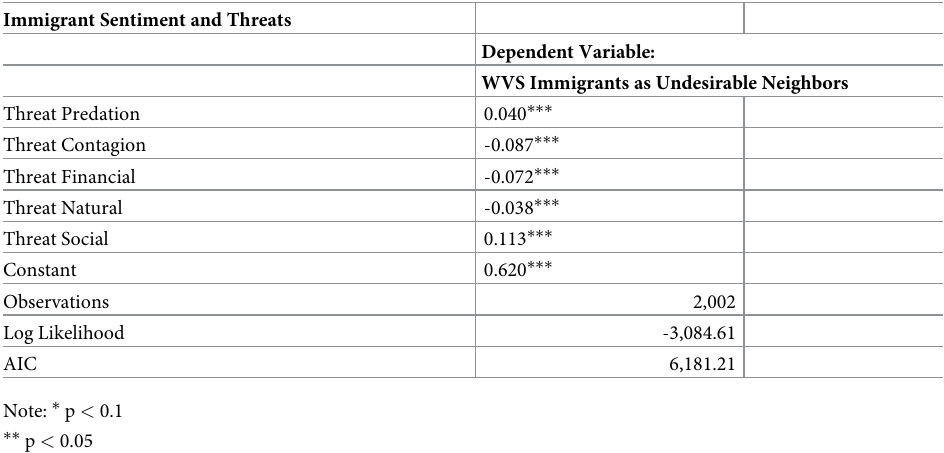
Table 3. Results of GLM to assess effects of threat on anti-immigrant